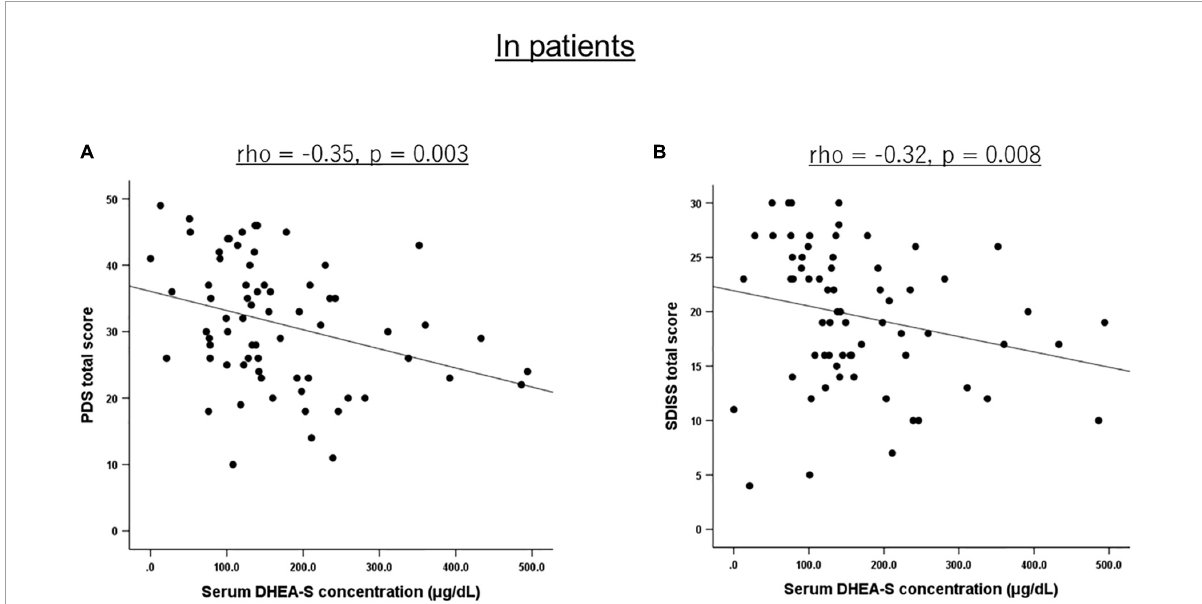
FIGURE1 Scatterplot showing the relationship of serum DHEA-S levels with PTSD severity and functional disability in patients. In PTSD patients, serum DHEA-S levels were significantly negatively correlated with (A) overall PTSD severity assessed with the PDS total score and (B) functional disability assessed with the SDISS total score. Correlation was calculated by the Spearman’s rank order correlation.